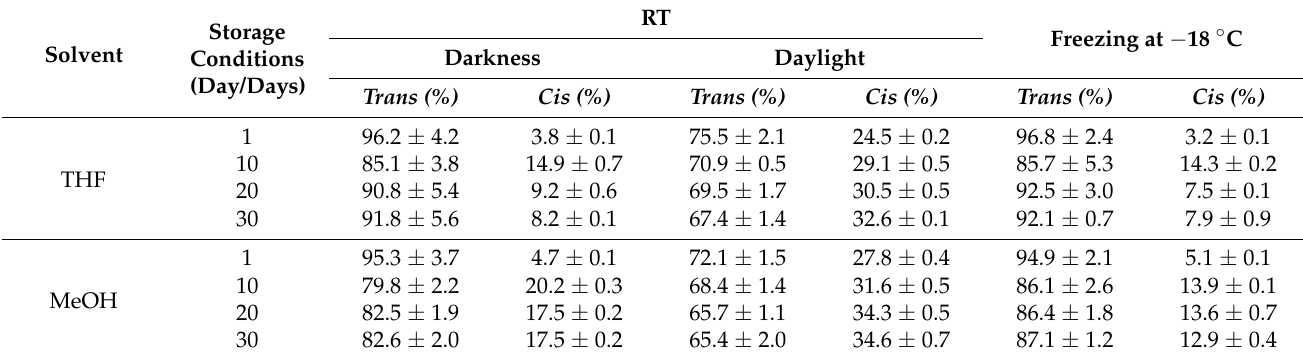
Table 1. Isomerization of trans-CA dissolved in THF or MeOH under the influence of various storage conditions.